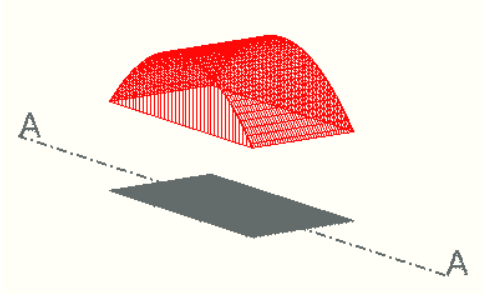
Figure 17: Parabolic load distribution along the cross-sections of a wheel with rectangular tire-ground contact area (the A-A vertical section is taken along the cross-section of the wheel).